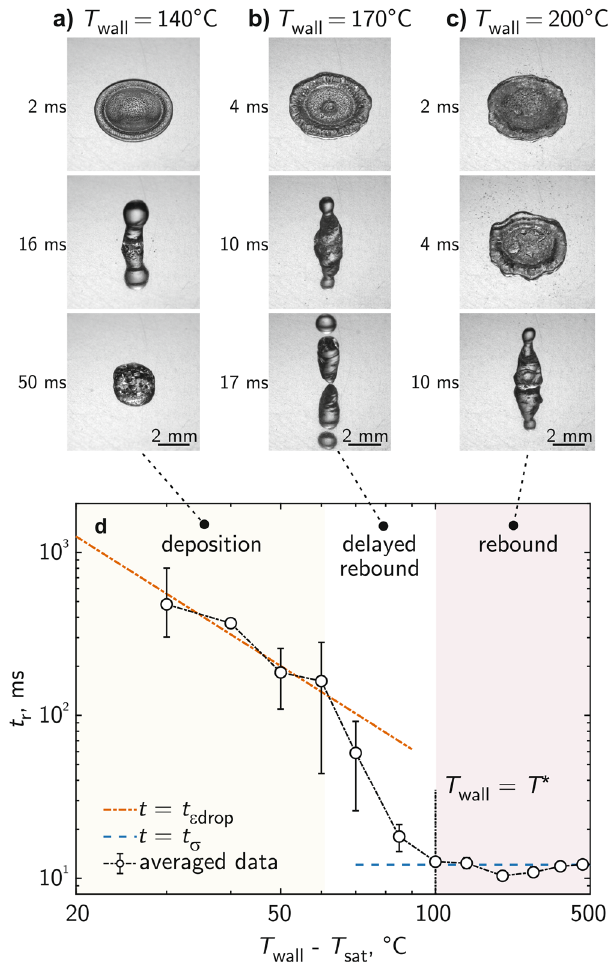
Fig. 1 Typical stages and main outcomes of drop impact onto a hot solid substrate at various initial temperatures. The fi gure shows a water drop with an initial drop diameter d 0 = 2.35 mm impacting onto an aluminum substrate with the impact velocity U 0 = 0.7 m s − 1 . a , b , and c are exemplary images of drop impacts captured using a high-speed video system. All images are top view observations at an angle of 60 ∘ to the surface. a Drop impact at initial substrate temperature of T wall = 140 °C shows drop spreading, receding, and deposition in the nucleate boiling regime. The contact residence time is determined by complete drop evaporation; b T wall = 170 °C intensive nucleate boiling leads to the drop rebound delayed by a short period of sticking (see the image at 10 ms); c T wall = 200 °C, non- sticking drop rebound; d Dependence of the average contact residence time t r on the wall overheat temperature T − T wall sat in comparison with the theoretical estimations for the total evaporation time of a deposited drop t ϵ t σ . Each point is the average value drop and the drop natural oscillation time for experimental determined residence times in the corresponding temperature class. The error bars show the minimum and maximum observed residence times during